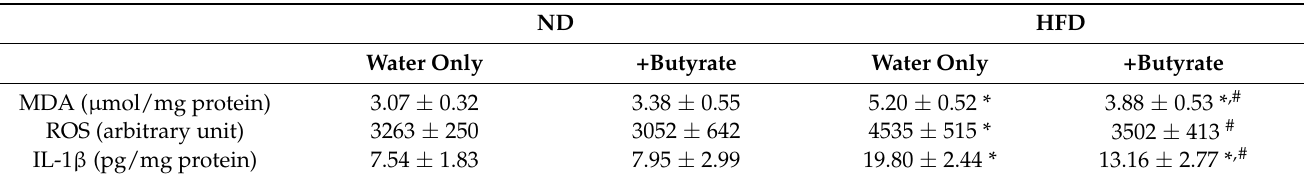
Figure 8. Tissue levels of acetate, propionate, or acetate ( A ), percentage change in the expression of GPR41 or olfr78 mRNA ( B ) in the PVN, and SBP, plasma NE levels, and power density of LF component of SBP ( C ) in adult ND or HFD offspring, alone or with oral supplement in HFD offspring with butyrate (2 g/kg/day) for six weeks. Also presented is the schematic diagram of the experimental design. Data are presented as mean ± SD, n = 7 in each group. * p < 0.05 vs. ND group, and # p < 0.05 vs. HFD group in the post hoc Tukey’s multiple-range test. Table 1. Effect of oral supplement with butyrate on markers of oxidative stress and neuroinflamma- tion in the PVN of adult HFD